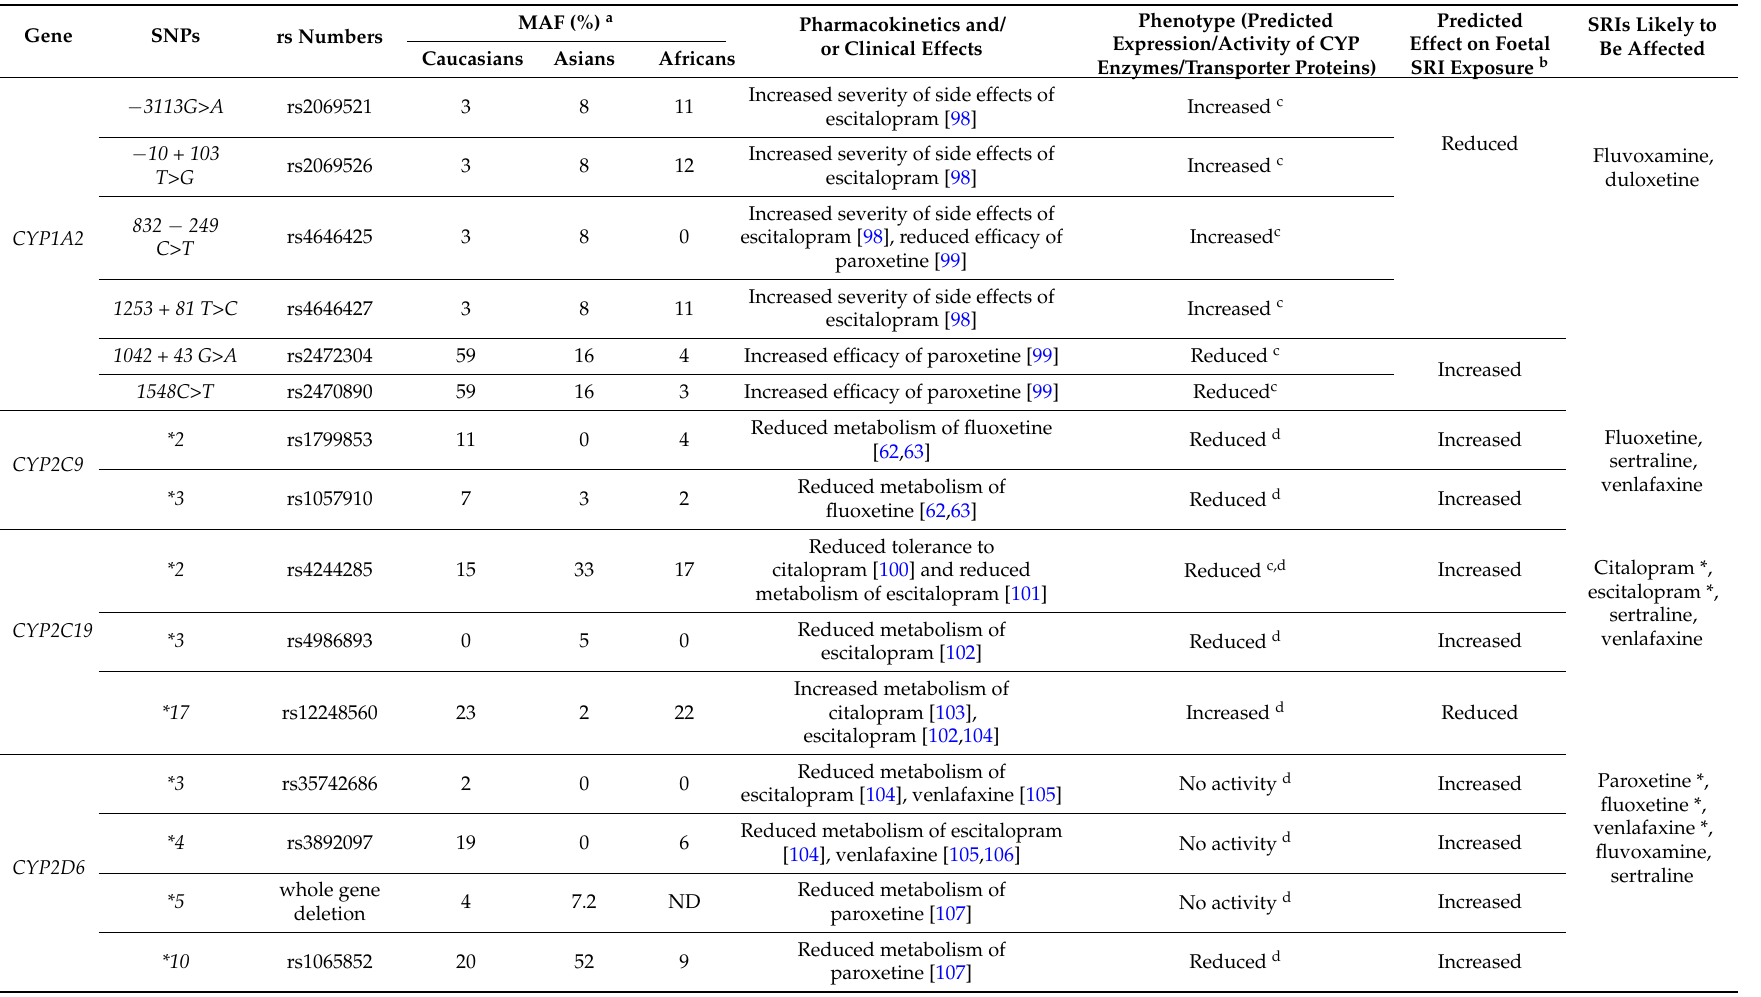
Table 1. Overview of polymorphisms significantly associated with serotonin reuptake inhibitors (SRIs) pharmacokinetics and their predicted effect on foetal SRI